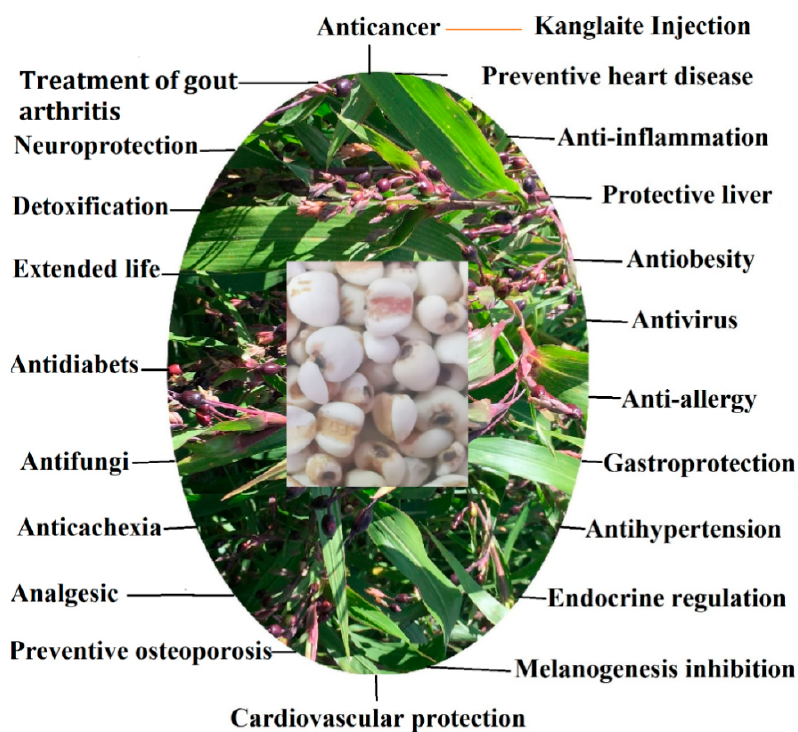
Figure 1. Functional ingredients of adlay combat more than 20 chronic diseases.